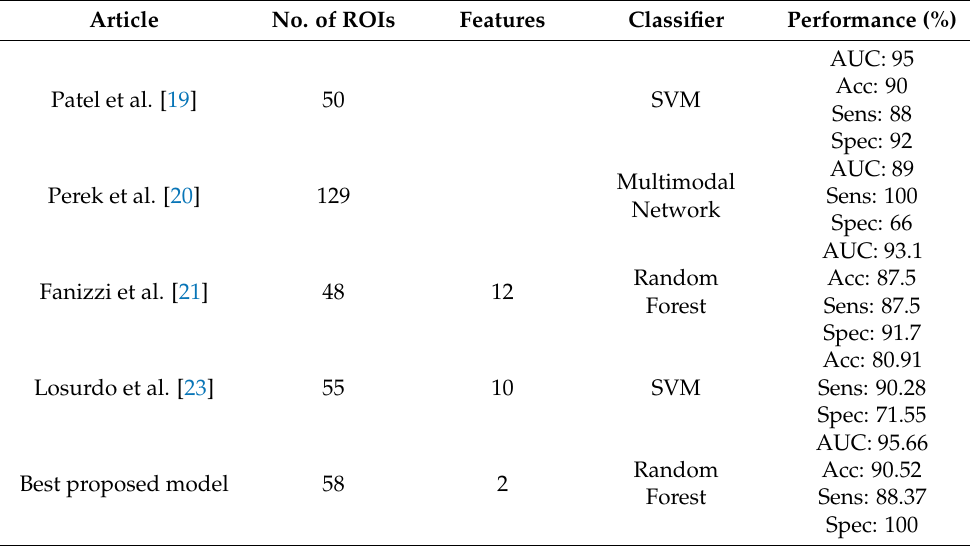
Table 4. Benign vs. malignant breast lesion classification evaluated on CESM images: comparison of the performance results of the proposed models in the